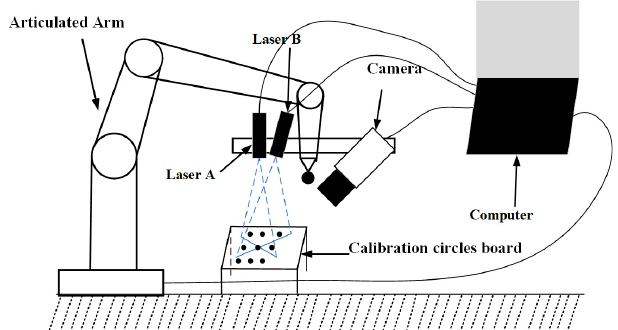
Figure 1. Schematic measuring arm-mounted cross-line structured-laser scanning system.